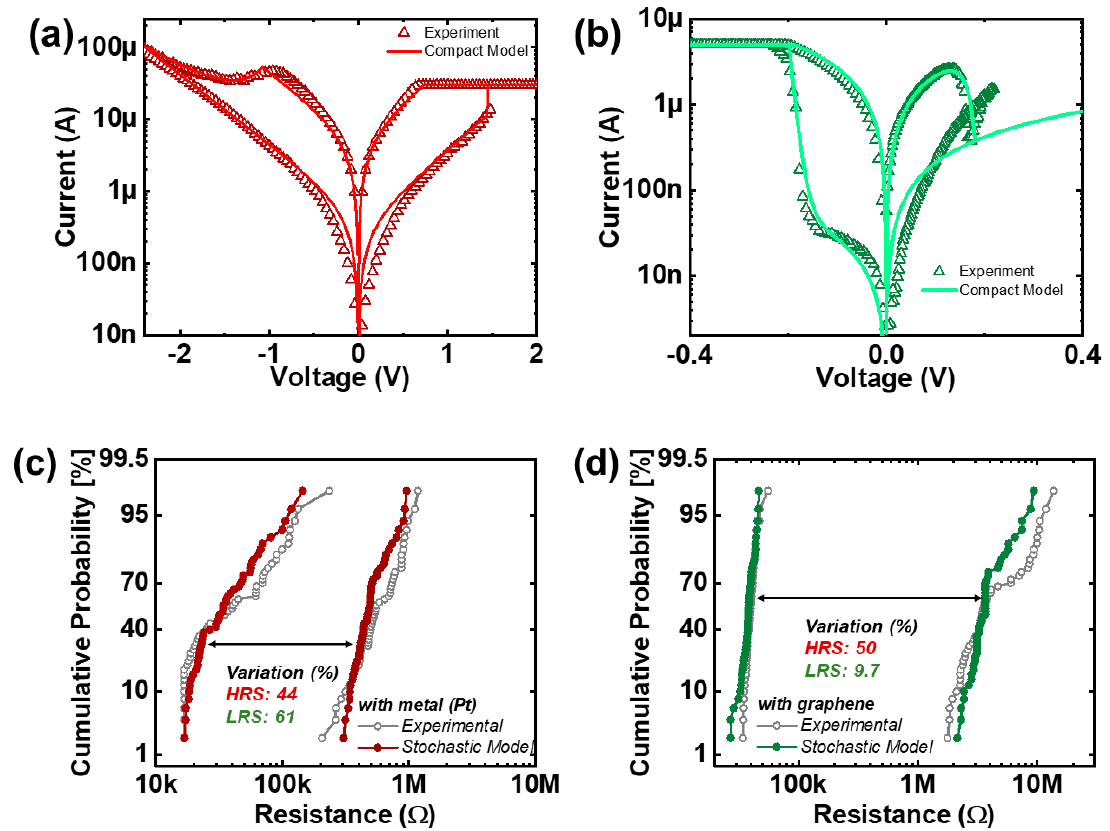
Figure 6. Experimentally verified Verilog-A compact model fitting of the VRRAM with ( a ) Pt and ( b ) graphene electrodes; ( c , d ) The resistance distribution from the experimental measurements and models with an injected stochastic feature for the Pt- and graphene-based VRRAM, respectively.